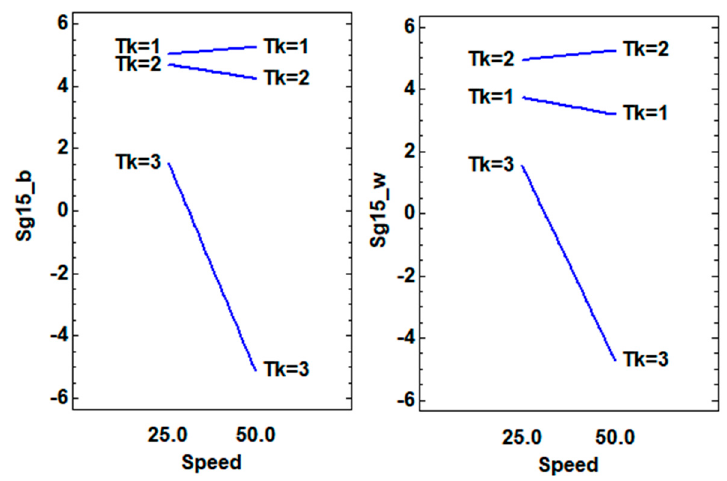
Figure 7. Interaction plots (printing speed (A) and sample thickness (C) factors) for the sparkle values at 15° on the white (_w) and black (_b) backgrounds.